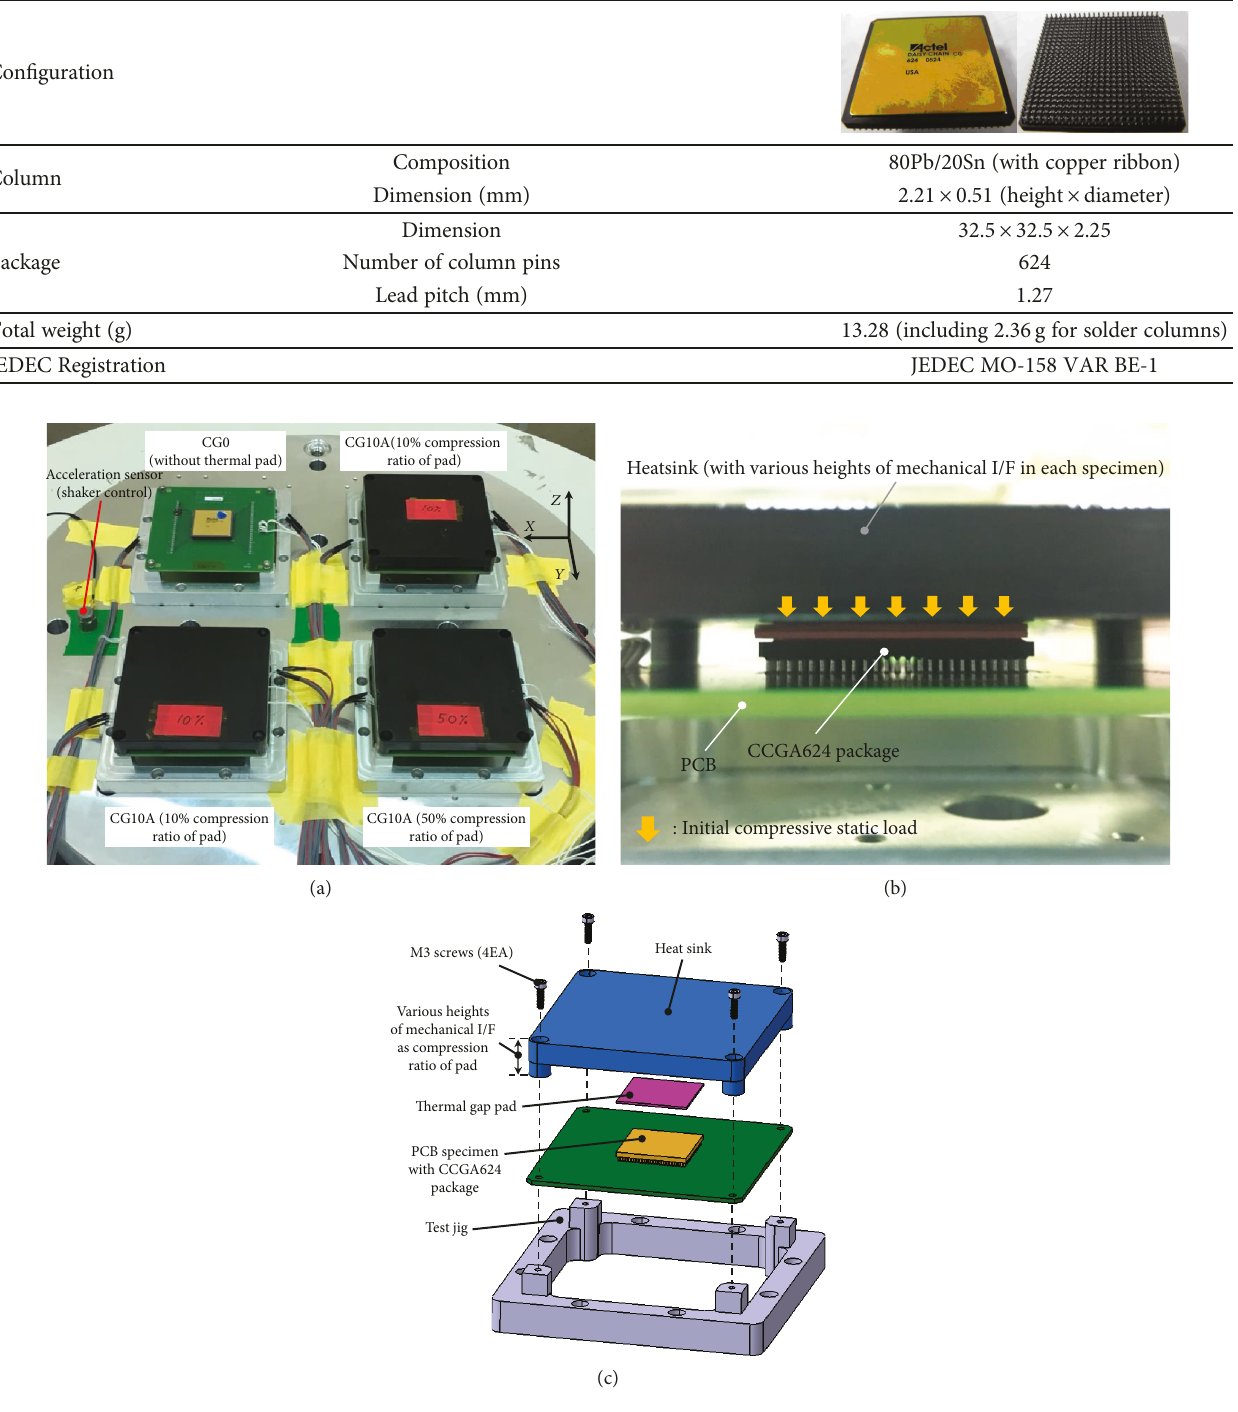
Figure 6: Random vibration fatigue test setup ((a) Overall view (b) Close-up view of the thermal gap pad (c) Exploded joint after 5.38 minutes of excitation. This specimen was dis- assembled from the test set-up after 20min because the pack- Table 4. The resistance value of the CG0 specimen rapidly age could be excessively damaged if the test was continued. reached the 10.5 k Ω value de fi ned as a failure of the solder